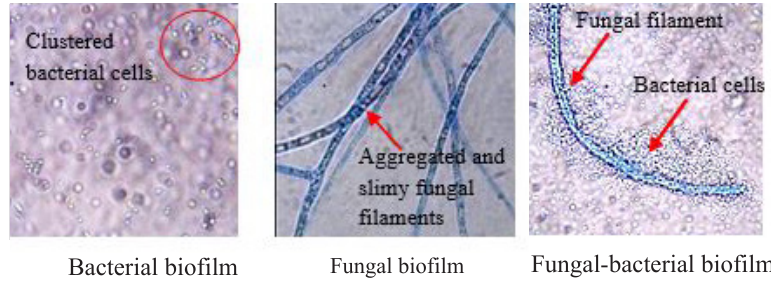
Figure 3: Morphological differences of three types of biofilms - fungal (FB), bacterial (BB) and fungal-bacterial (FBB). Magnification x 1000.